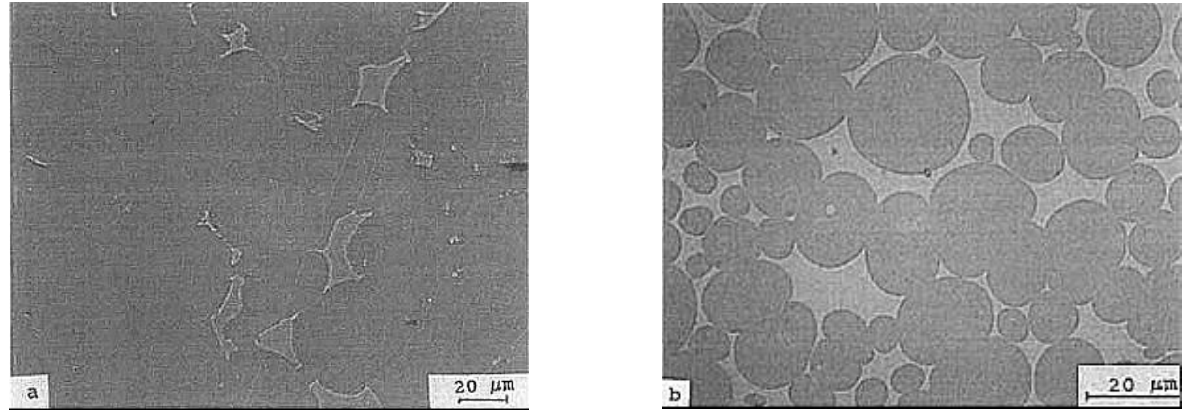
Figure 4. Microstructure of 82W–8Mo–8Ni–2Fe sintered at 1500 ◦ C for 480 min: ( a ) slowly cooled; ( b ) water-quenched [57]. Reproduced with permission from Kemp and German, Journal of the Less Common Metals; published by Elsevier, 1991.